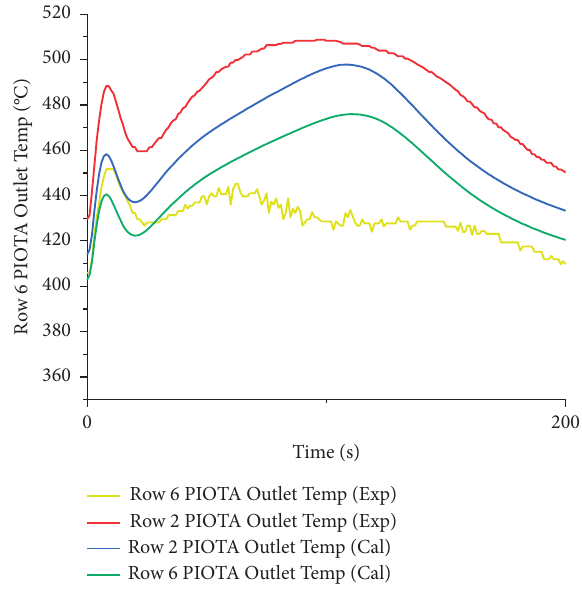
Figure 22: Row 2 and row 6 PIOTAs outlet temperature (0s–200s).